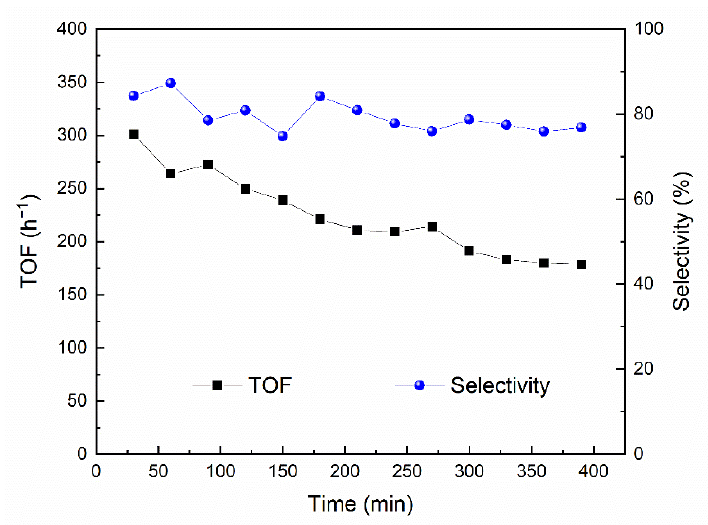
Figure 8. Stability test of 2-methyl-2-pentenal hydrogenation with 6 wt.% Co/CNR115 at 60 bar and 100 °C.